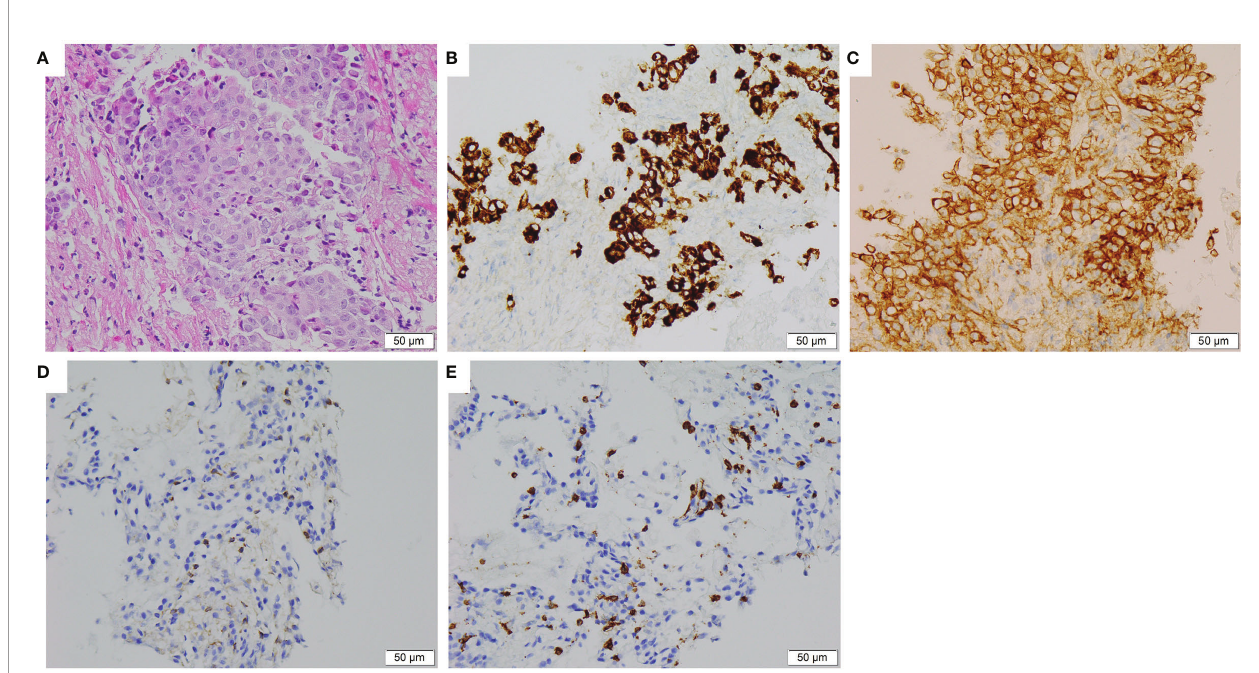
FIGURE 1 | Histopathological and immunohistochemical staining of the lung tumor tissue sample. (A) Hematoxylin and eosin staining showing a poorly differentiated adenocarcinoma of primary biopsy (400×). (B) IHC staining showed ALK overexpression in 95% tumor cells of primary biopsy (400×). (C) IHC staining showed PD- L1 expression with Tumor Proportion Score 60% of primary biopsy (400×). (D, E) IHC staining CD4 and CD8 expression on T cells of rebiopsy showed that CD8 was positive (about 10%), and CD4 was only in fi ltrated individually (400×). IHC, immunohistochemical; ALK, anaplastic lymphoma kinase; PD-L1, Programmed cell death 1 ligand